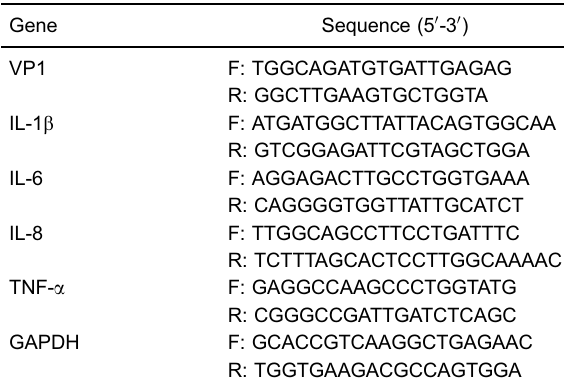
Table 1. Primers used for real-time PCR.